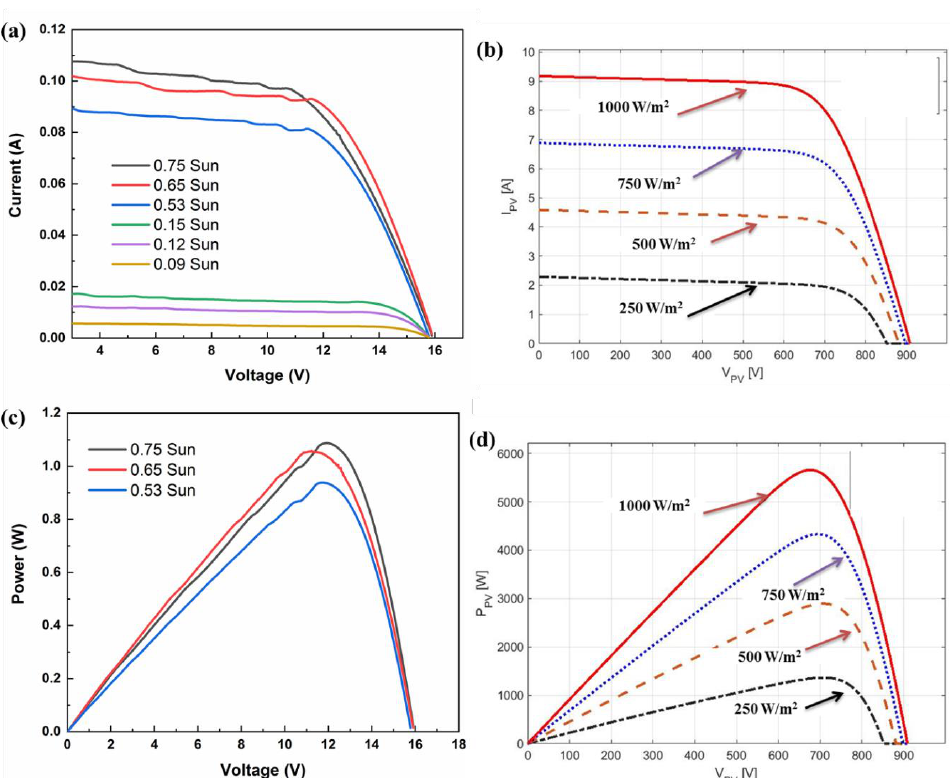
Figure 3. The DSSC module ’s ( a , c ) and the designed array ’s ( b , d ) characteristics (current and power) at different irradiation levels.